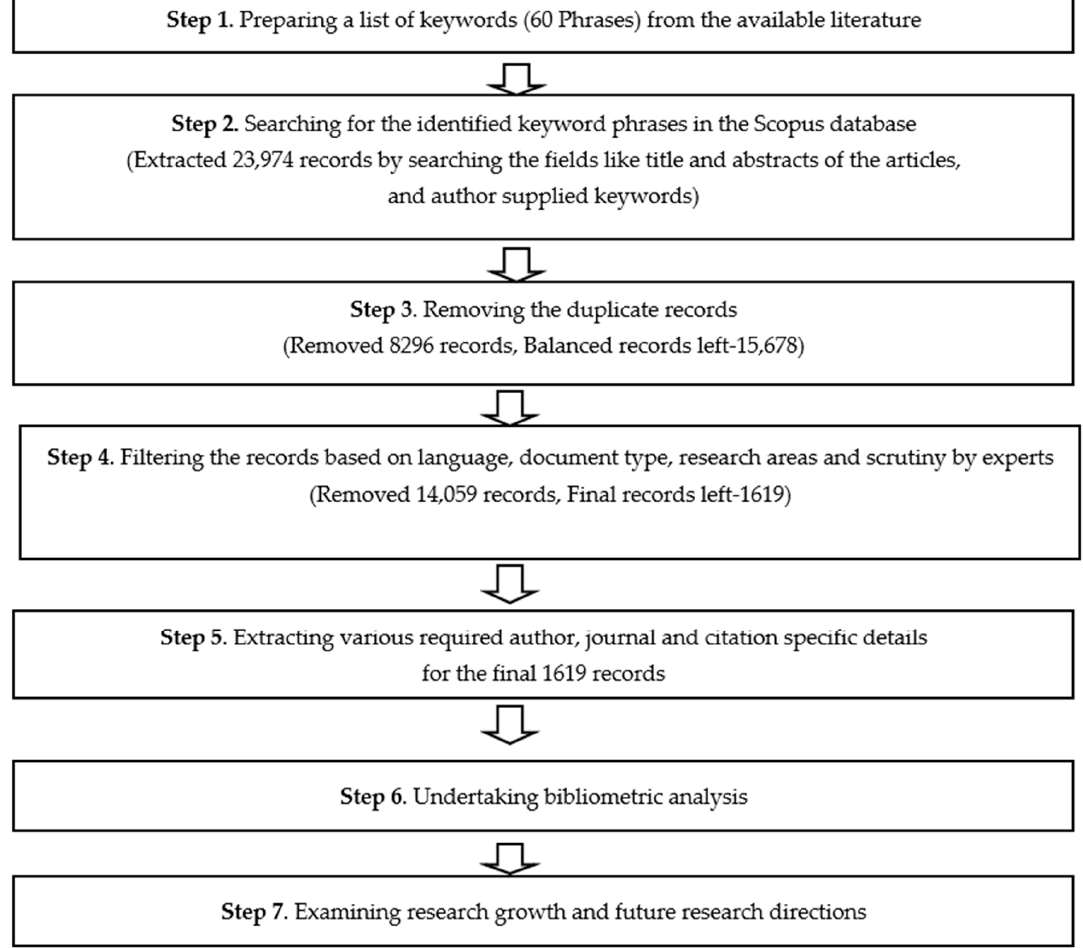
Figure 1. Data collection and analysis approach.